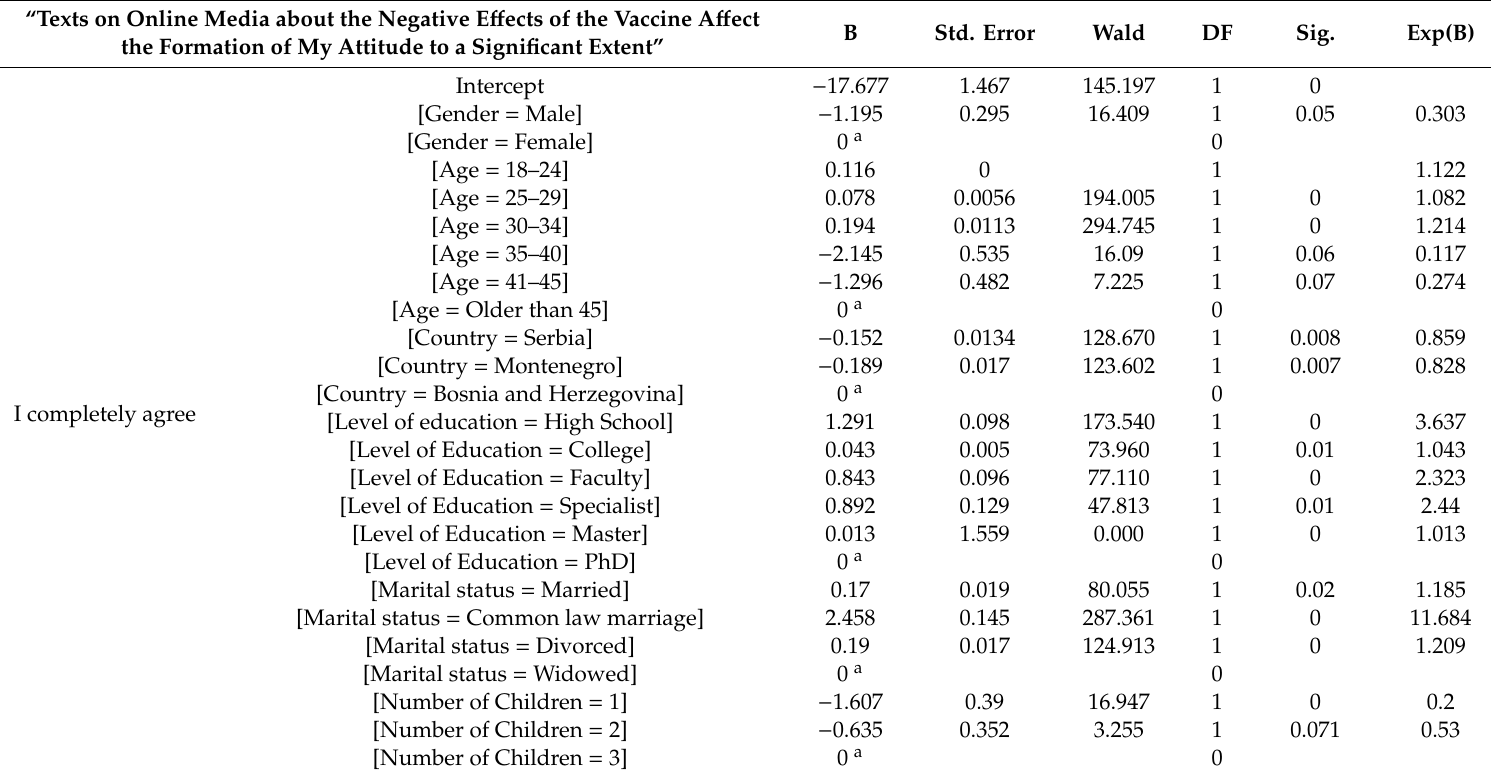
Table 5. Logistic regression of negative attitude of parents towards vaccines formed on the basis of information from online media. “Texts on Online Media about the Negative E ff ects of the Vaccine A ff